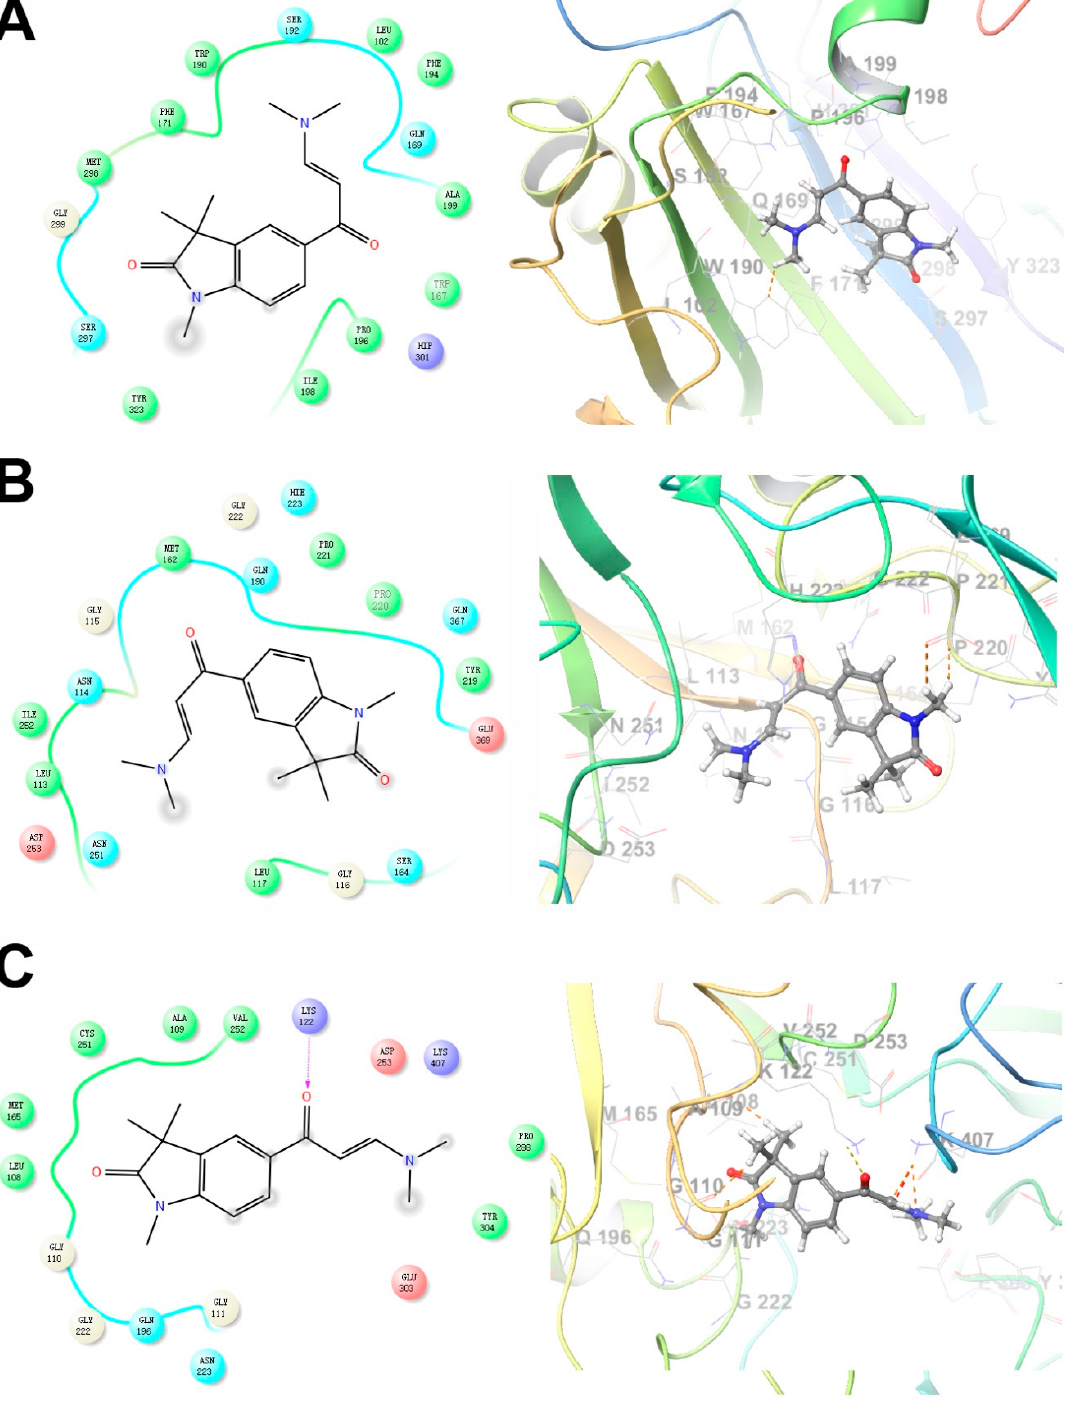
Figure 5. Cont Figure 5. Cont.